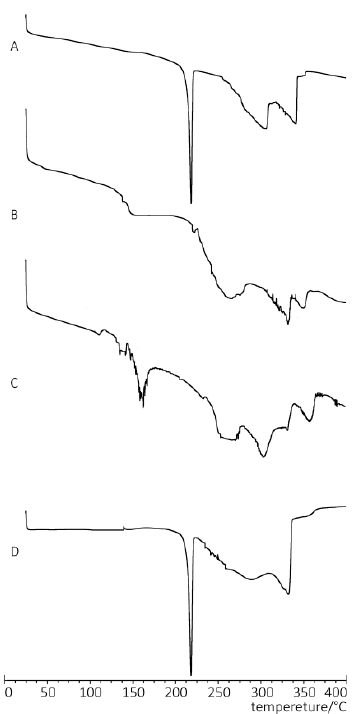
Figure 3. DSC thermograms of: ( A ) free PPD; ( B ) phospholipids; ( C ) PPD-phospholipid complex (PLC); and ( D ) physical mixture of PPD and phospholipids.